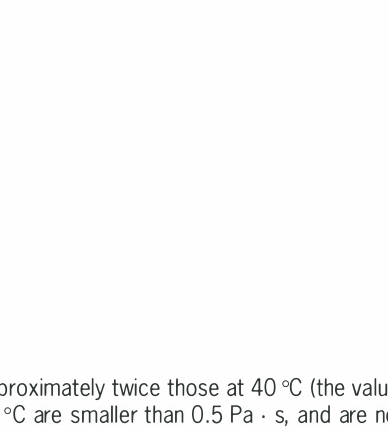
Fig. 4: Temperature-viscosity behavior of an ERF with and without an applied electric